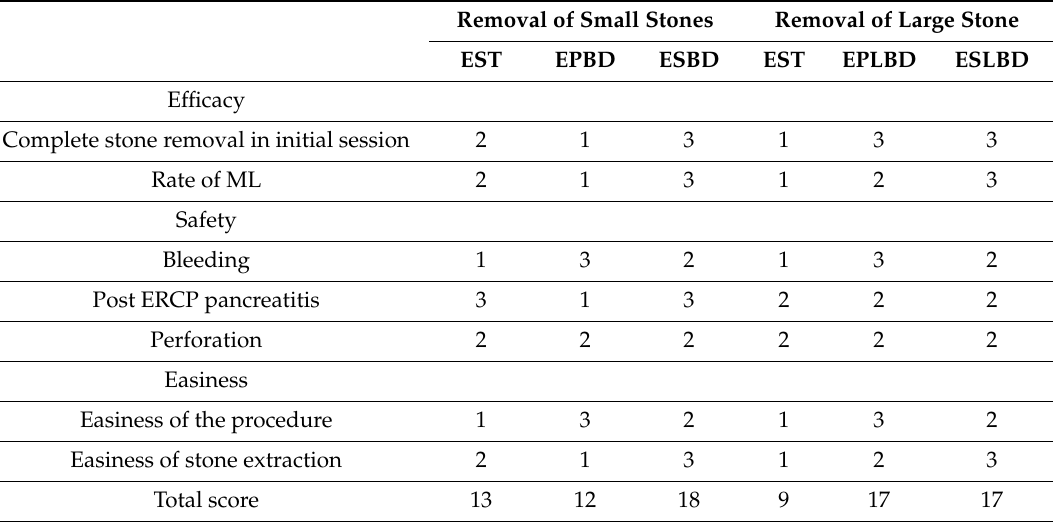
Table 5. Ranking in e ffi cacy, safety and ease of the